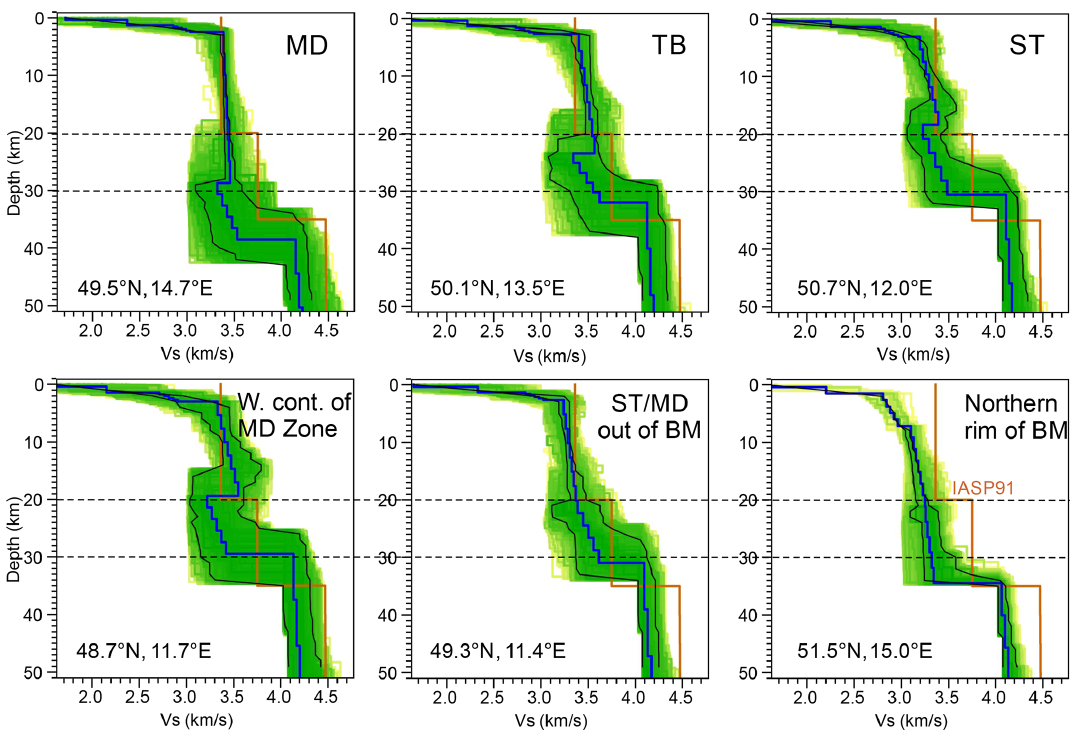
Figure 7. Examples of v S models, characteristic of individual tectonic units (for the abbreviations, see Fig. 1 and the text). The blue curve is the average model calculated from 10% of the best-fitting models from the 400000 models in total (yellow to green curves). The thin black curves frame 1% of the best-fitting models. The corresponding dispersion curves are shown in Fig.